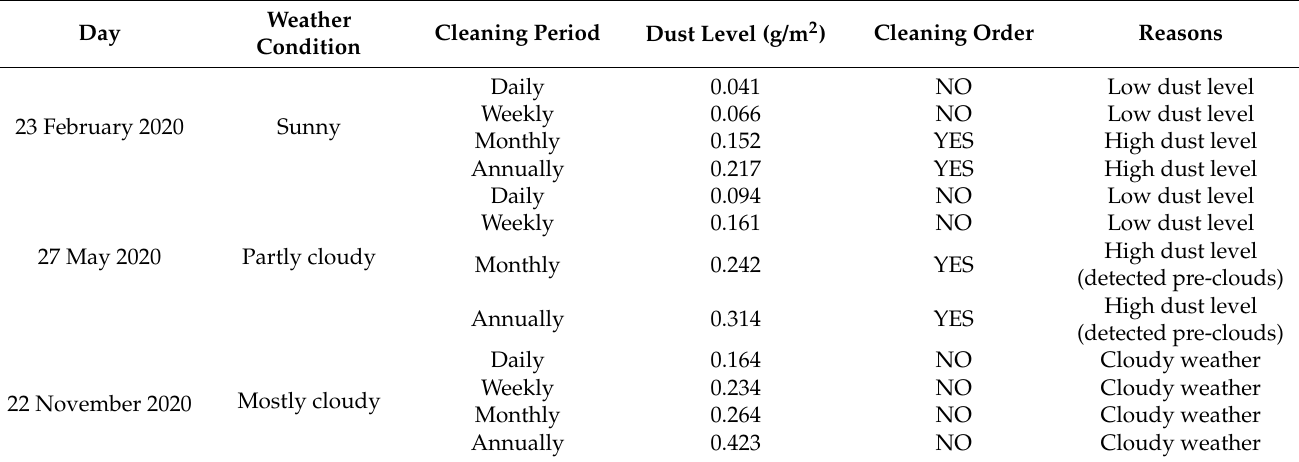
Table 4. Outcome results of the proposed AI system under different days, weather conditions, and dust